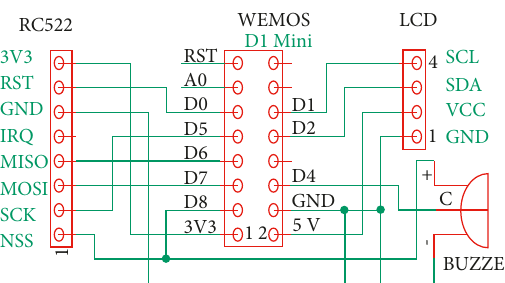
Figure 5: Hardware wiring for the card